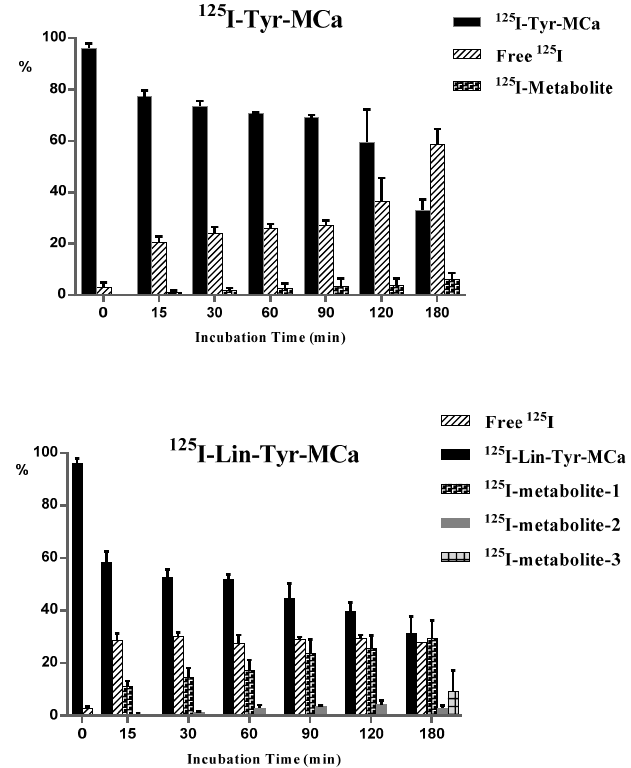
Figure 2. Evaluation of 125 I-Tyr-MCa and 125 I-Lin-Tyr-MCa stabilities following 15 to 180 min